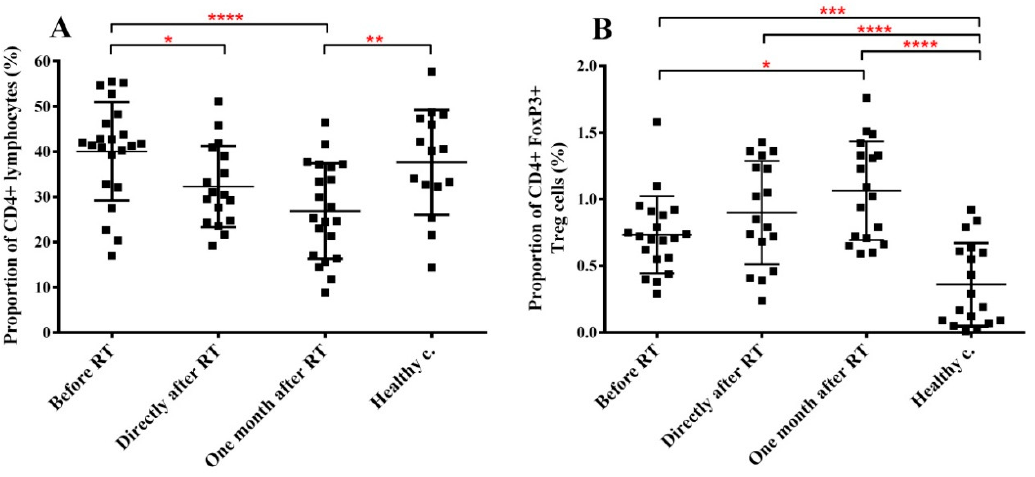
Figure 3. Radiotherapy reduces the total CD4 + T cell pool but increases the Treg pool within the lymphocyte population of H&N cancer patients. PBMCs were isolated from RT-treated H&N cancer patients, processed and labelled with the corresponding antibodies as described in Materials and methods s. ( A ) fraction of CD4 + cells within the lymphocyte gate. ( B ) fraction of CD4 / Foxp3 double positive cells within the lymphocyte gate. Student’s paired t -test was used to test significant di ff erences among the three time points of cancer patients’ samples, while unpaired t -test was used to test significant di ff erences between the three time points and healthy control group using 95% confidence interval. Data are shown as individual data points together with the mean ± SD (cancer patients n = 23, healthy controls n = 15). Significant di ff erences were indicated with * ( p < 0.05), ** ( p < 0.01), *** ( p < 0.001) and **** ( p < 0.0001).